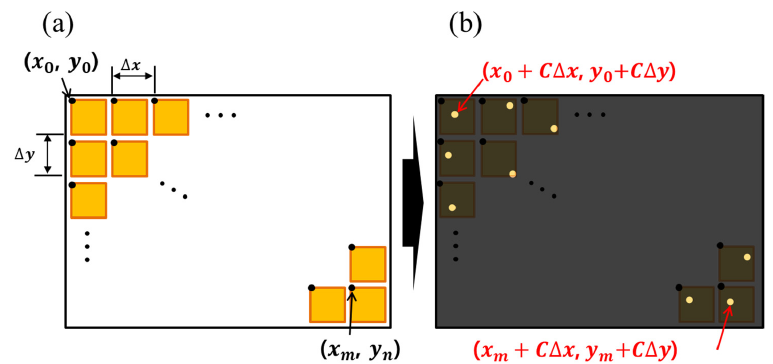
Figure 2. Basic schematics of ( a ) conventional periodic pixels and ( b ) the proposed non-periodic pinhole array filtering process.